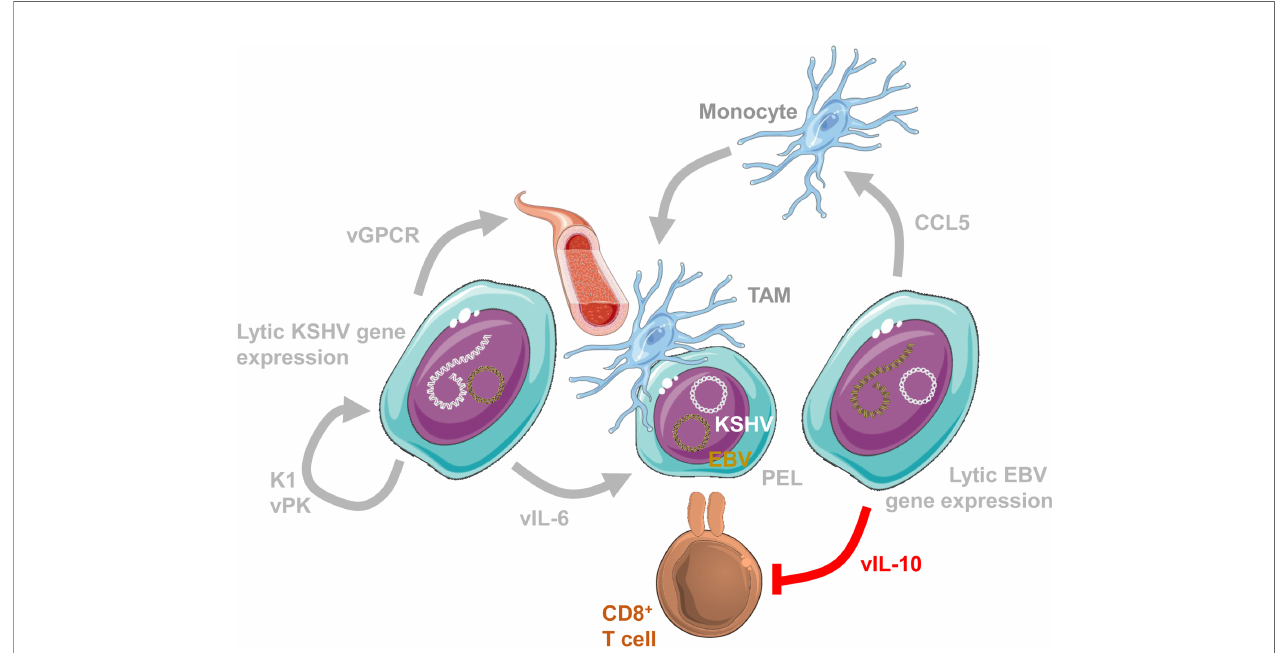
FIGURE 1 | Lytic EBV and KSHV gene expression condition the tumor microenvironment. Conditioning of the tumor microenvironment by lytic EBV and KSHV gene products occurs most likely at the same time in primary effusion lymphomas (PELs) that are 100% KSHV and 90% EBV infected. Lytic EBV replication attracts monocytes via CCL5 to become immune suppressive tumor associated macrophages (TAMs). Viral IL-10 (vIL-10; BCRF1) suppresses CD8 + T cell recognition. In addition, the lytic KSHV product viral G-protein coupled receptor (vGPCR; ORF74) promotes angiogenesis. Furthermore, K1 (ORF-K1) and viral protein kinase (vPK; ORF36) promote proliferation of KSHV infected cells. Finally, viral IL-6 (vIL-6; ORF-K2) promotes KSHV infected B cell proliferation. This fi gure was created in part with modi fi ed Servier Medical Art templates, which are licensed under a Creative Commons Attribution 3.0 unported license: